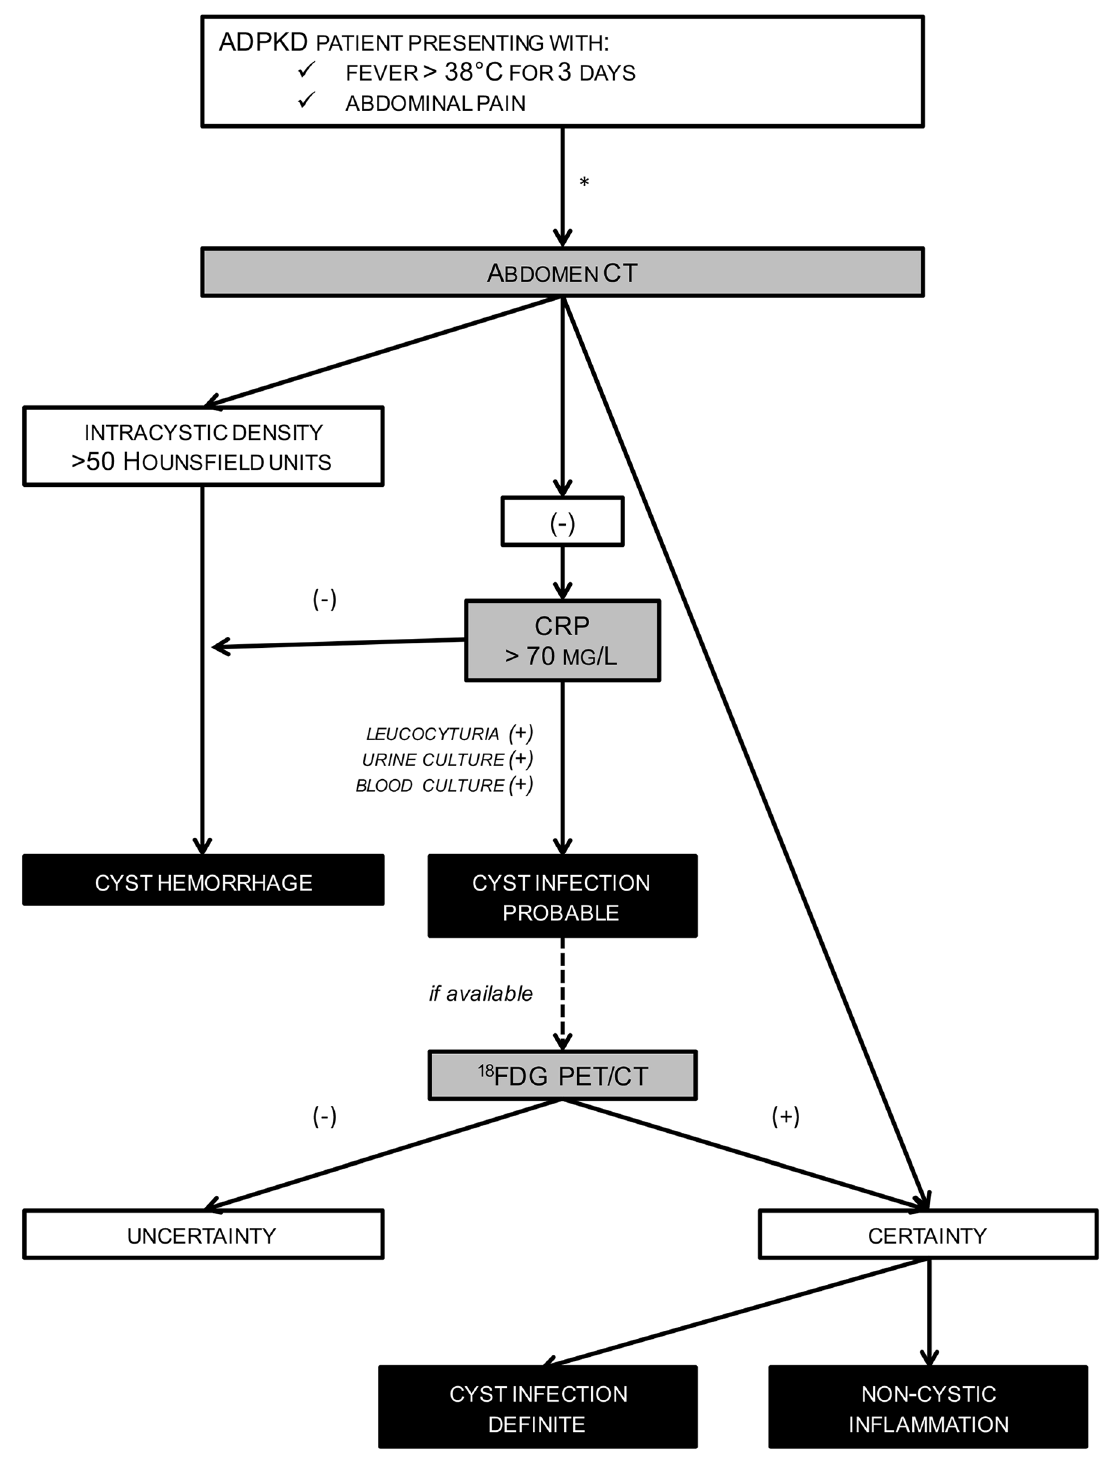
Fig 3. Diagnostic algorithm to manage patients with autosomal dominant polycystic kidney disease (ADPKD) presenting with suspected acute cyst complication. * , On the basis of the conventional management (including blood and urine analyses and abdomen imaging) of any patient with febrile abdominal pain in emergency conditions (33).